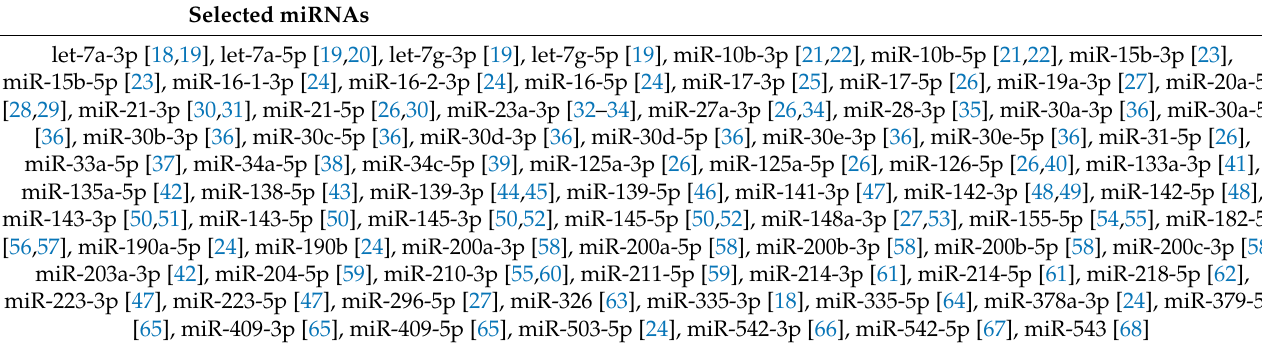
Table 1. Selected miRNAs and